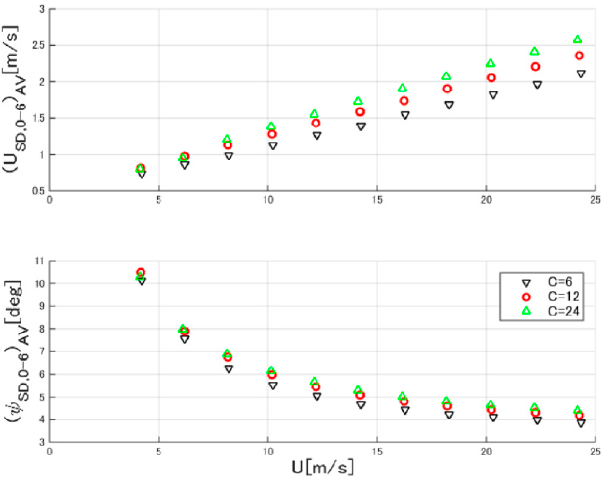
Figure 7. Average of the standard deviations of the wind speed and the yaw angle of seven wind turbines to the average wind speed at the centre hub.